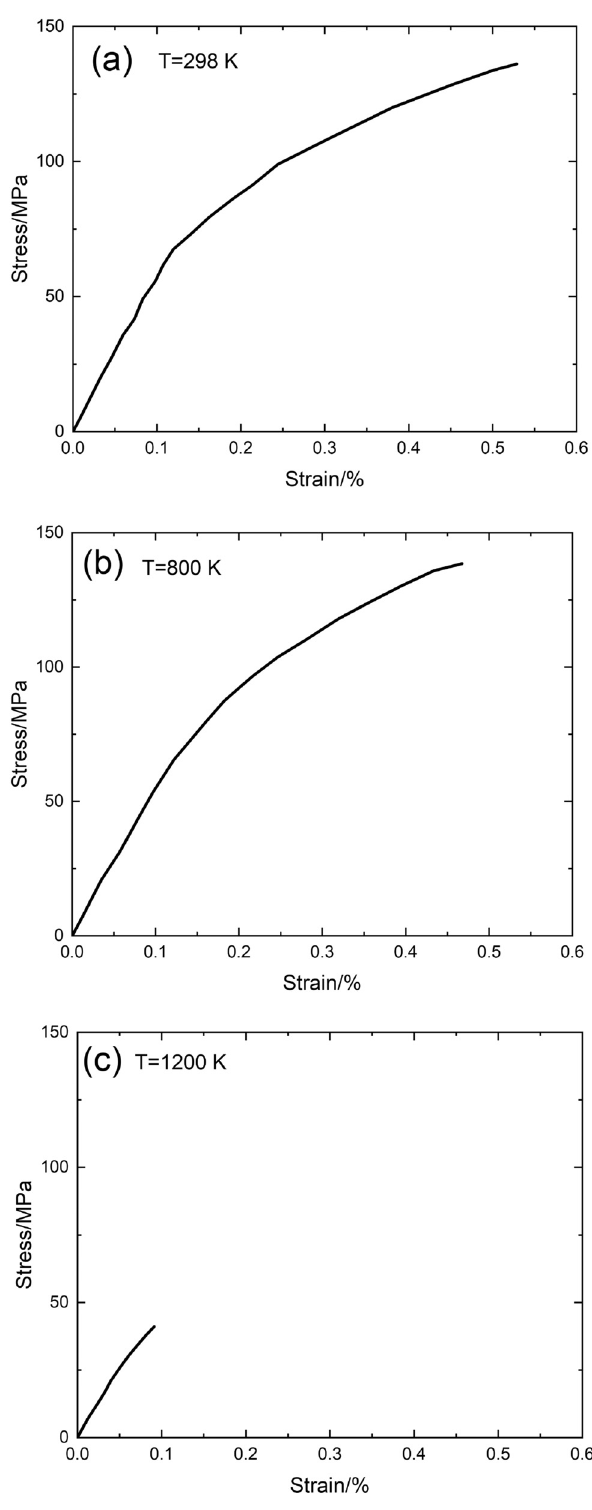
Figure 6: Experimental tensile stress – strain curves of Nicalon TM SiC/C/SiC at ( a ) T = 298 K, ( b ) T = 800 K, and ( c ) T = 1,200